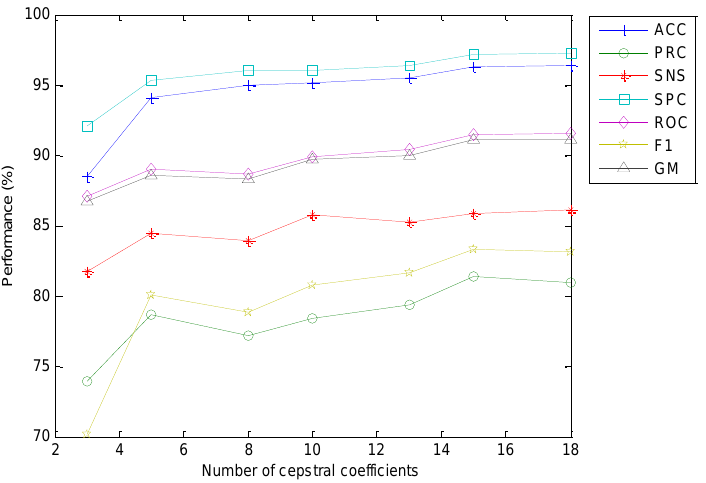
Figure 32. Classification performance metrics of the best classifier vs. the number of cepstral coefficients (optimal value in every option).